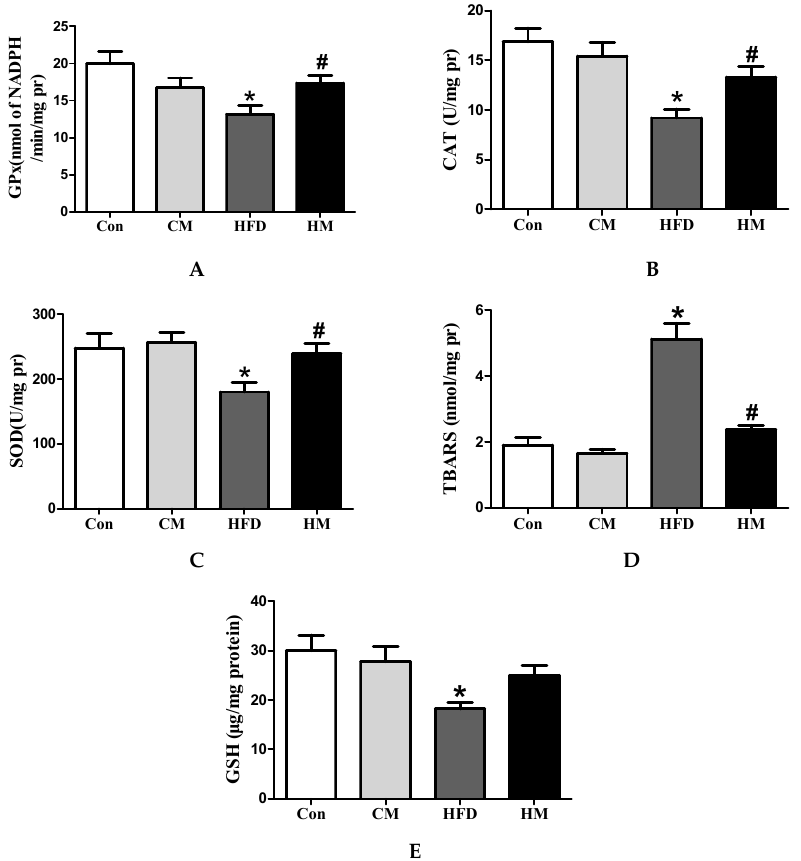
Figure 5. Myricetin alleviated hepatic oxidative stress induced by a high-fat diet. ( A ) GPx; ( B ) CAT; ( C ) SOD; ( D ) TBARS; and ( E ) GSH levels. Values were presented as mean ± SEM ( n = 8). Con, control diet; CM, control diet with additional 0.12% myricetin; HFD, high-fat diet; HM, high-fat diet with additional 0.12% myricetin. * p < 0.05 vs. the Con group; # p < 0.05 vs. the HFD group.